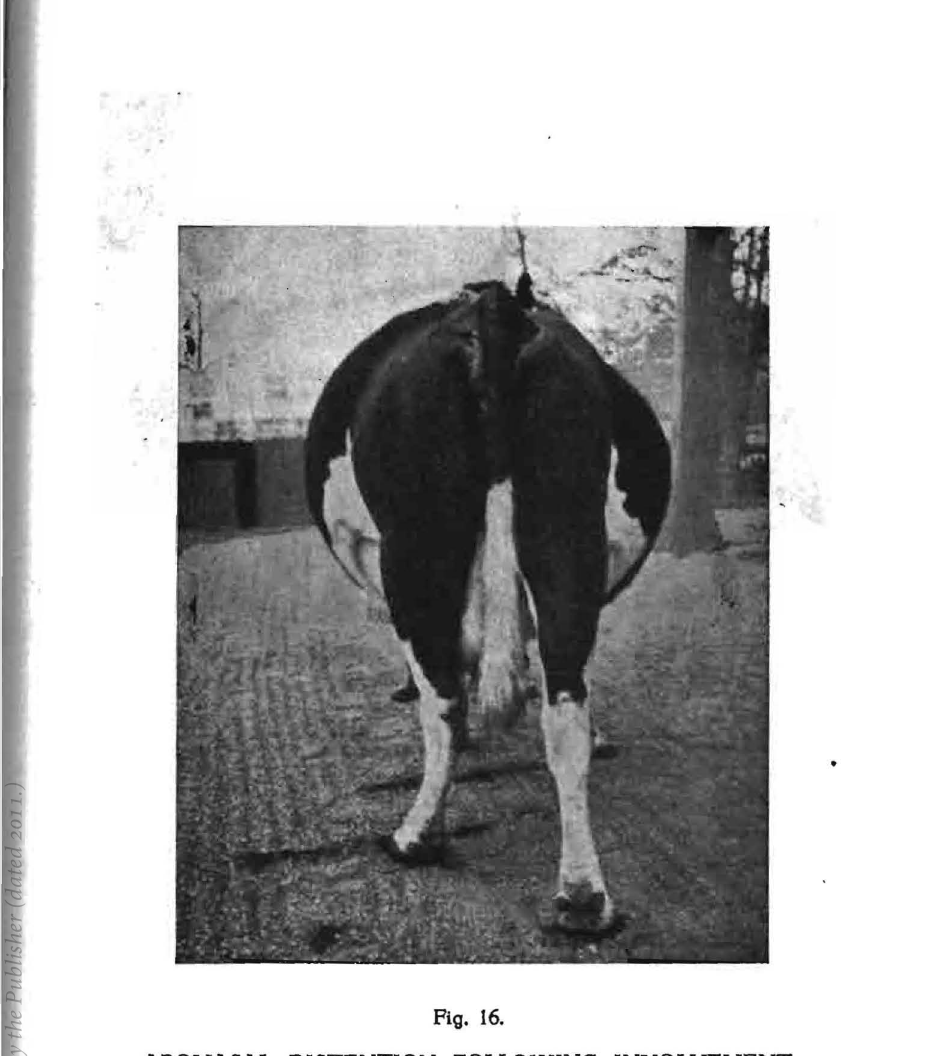
OF THE RIGHT VENTRAL BRANCH OF THE